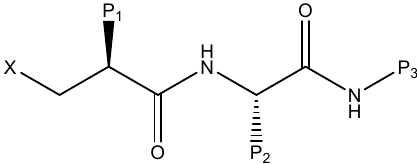
Figure 1. Proposed general structure for peptide deformylase (PDF) inhibitor.